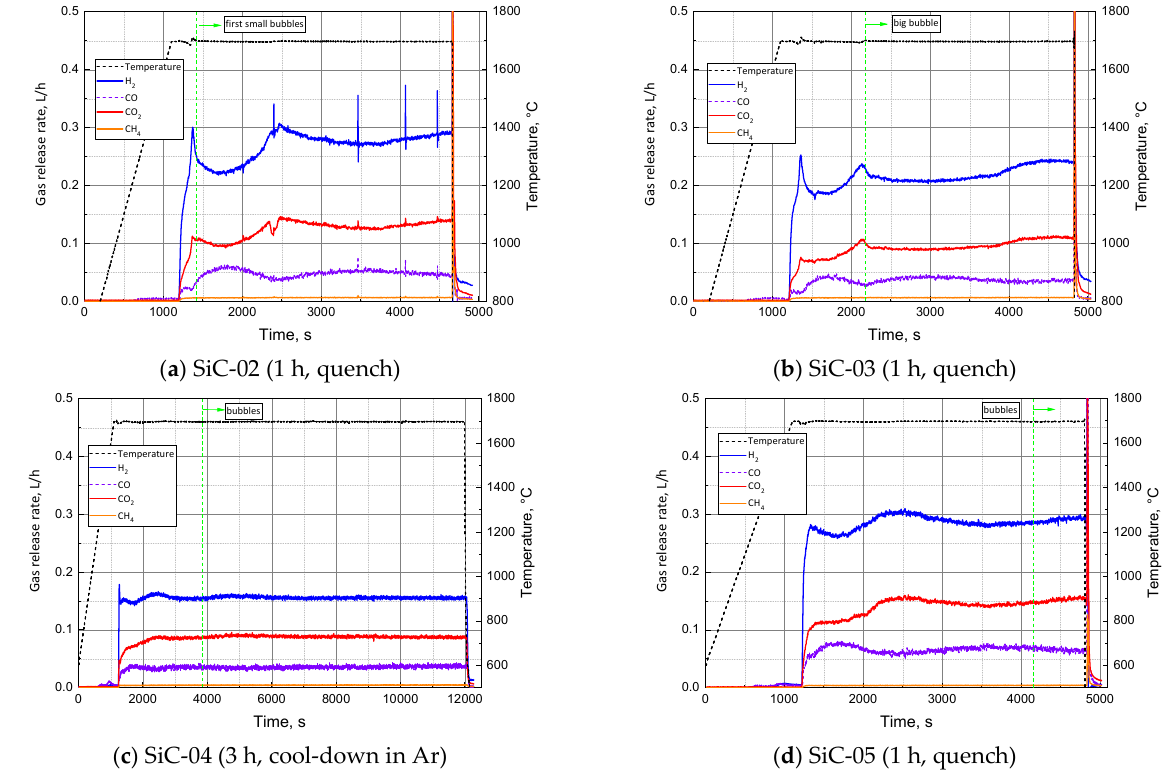
Figure 7. Temperature history and gas release rates during the isothermal tests at 1700 °C.